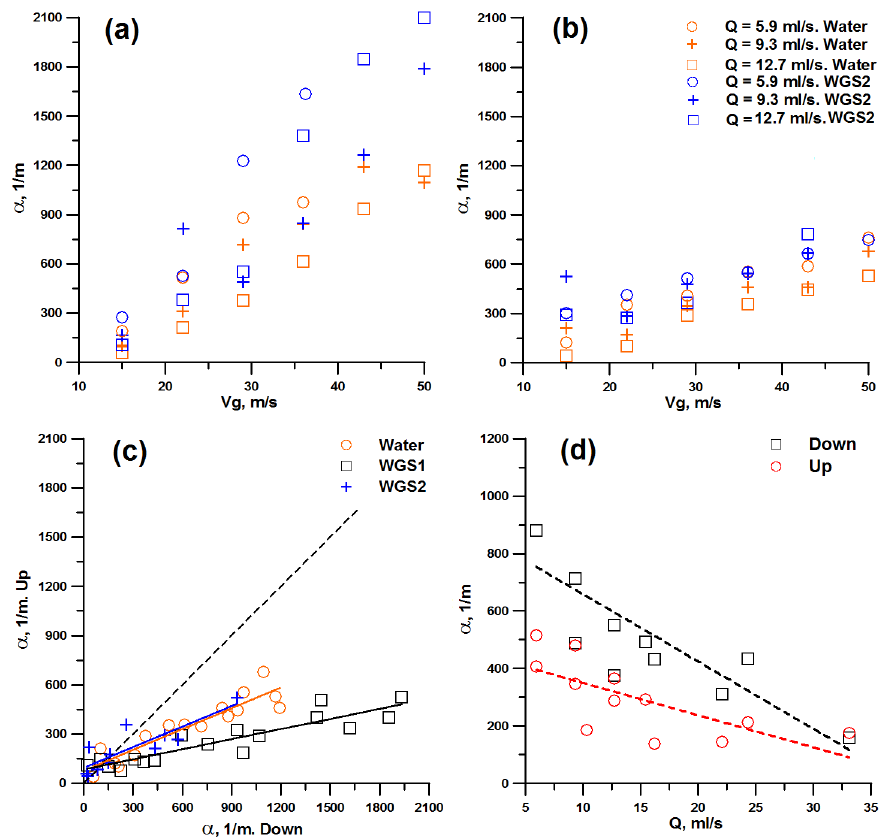
Figure 7. Increment of the amplitude growth of the initial waves. ( a , b ) The effect of liquid viscosity at a fixed liquid flow rate for the downward ( a ) and upward ( b ) flows. ( c ) The effect of flow orientation. ( d ) The effect of the liquid flow rate for a fixed gas velocity, V G = 29 m/s.